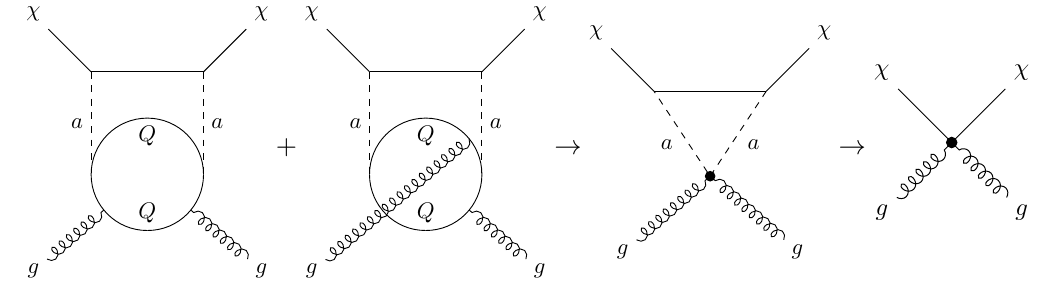
Q (cid:29) m a ; m (cid:31) . After